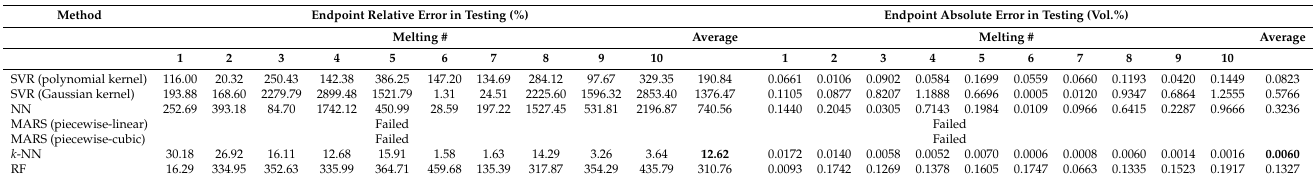
Table 17. Absolute and relative errors in carbon prediction based on dynamic